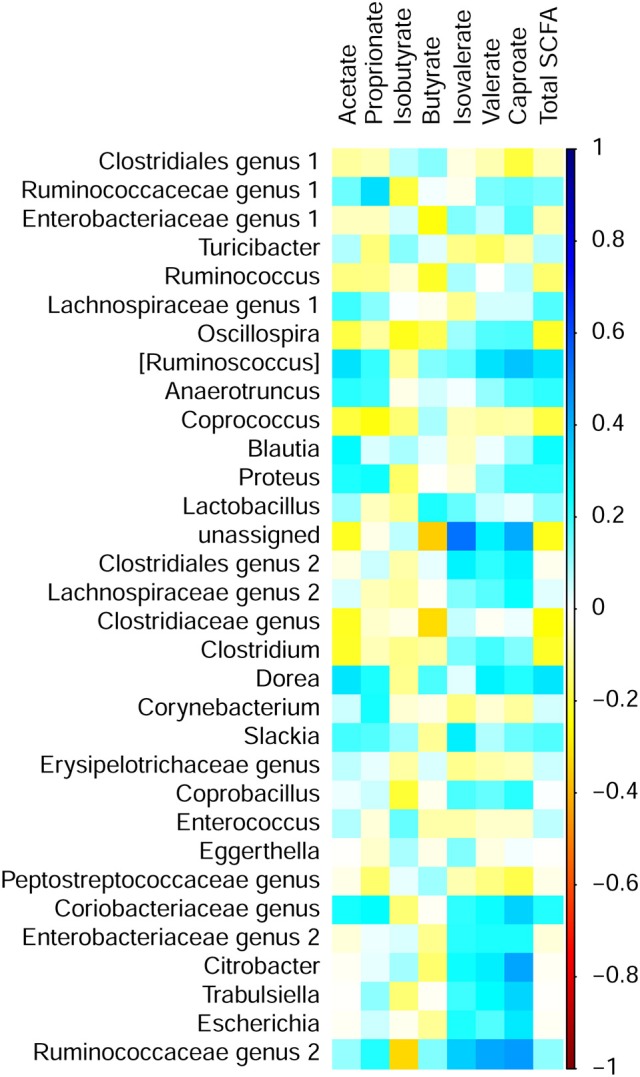
Correlation matrix between short chain fatty acid (SCFA) concentrations and relative abundance of bacterial genera in cecal digesta of chickens fed diets with increasing levels of deoxynivalenol (DON; 0, 2.5, 5, or 10 mg DON/kg diet) and with or without oral lipopolysaccharide challenge (LPS) 1 day prior to slaughter. Colors refer to the degree of correlation.